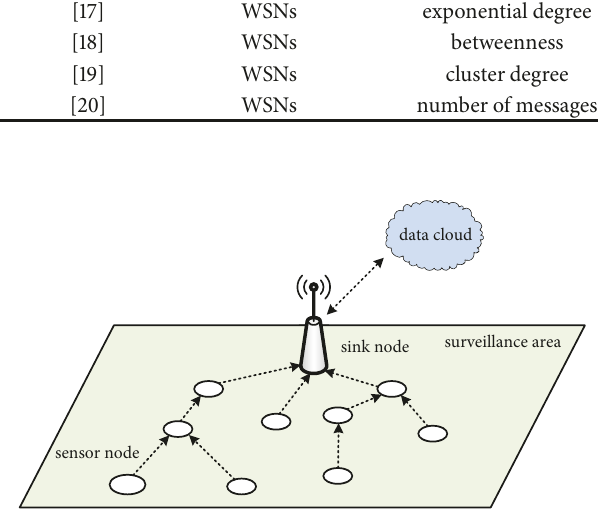
Figure 1: A sample of sink convergence in